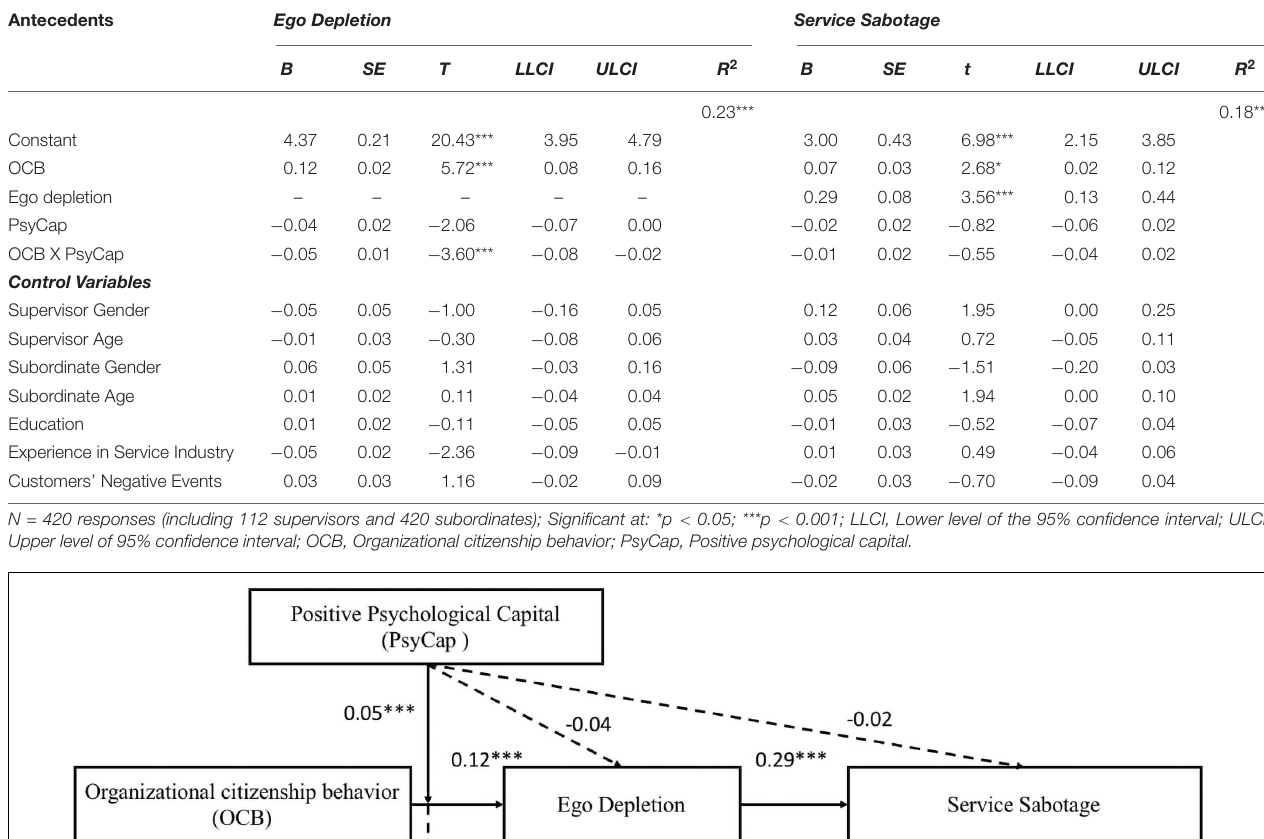
TABLE 3 | Results of the moderated-mediation model analysis.